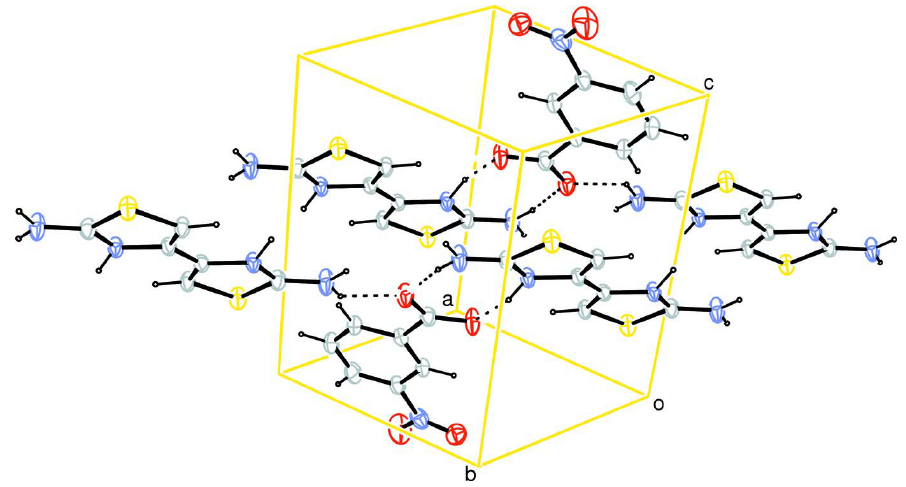
Figure 1 The molecular structure of the title salt, with 30% probability displacement ellipsoids (arbitrary spheres for H atoms), dashed lines showing the hydrogen bonding within the complex [symmetry code: (i) 2 - x ,1 - y ,1 - z ].